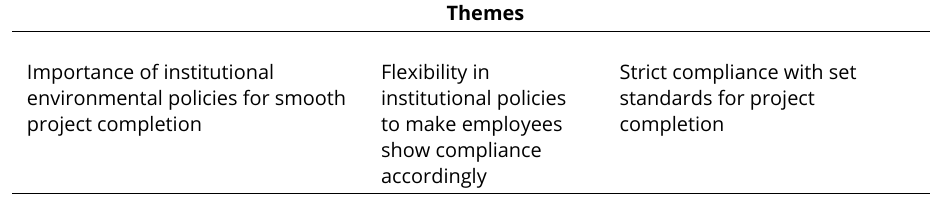
Themes and Codes